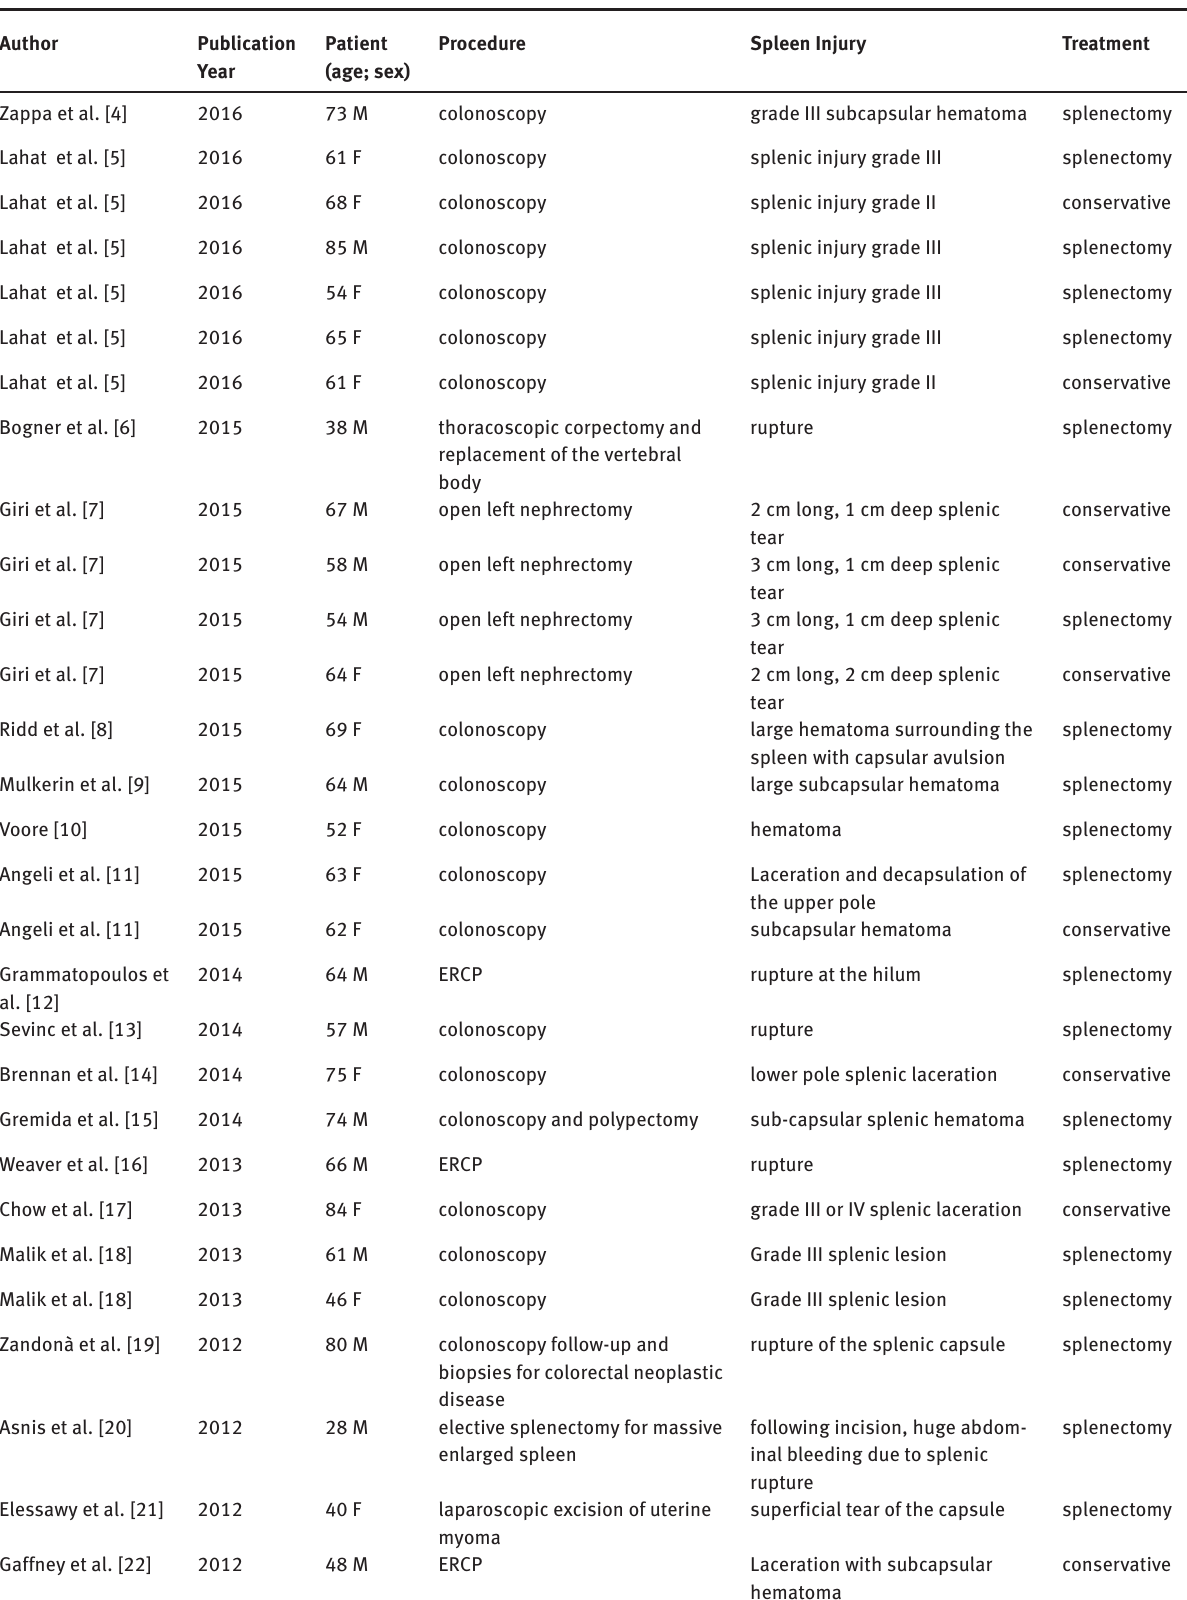
Table 1: Cases selected from the